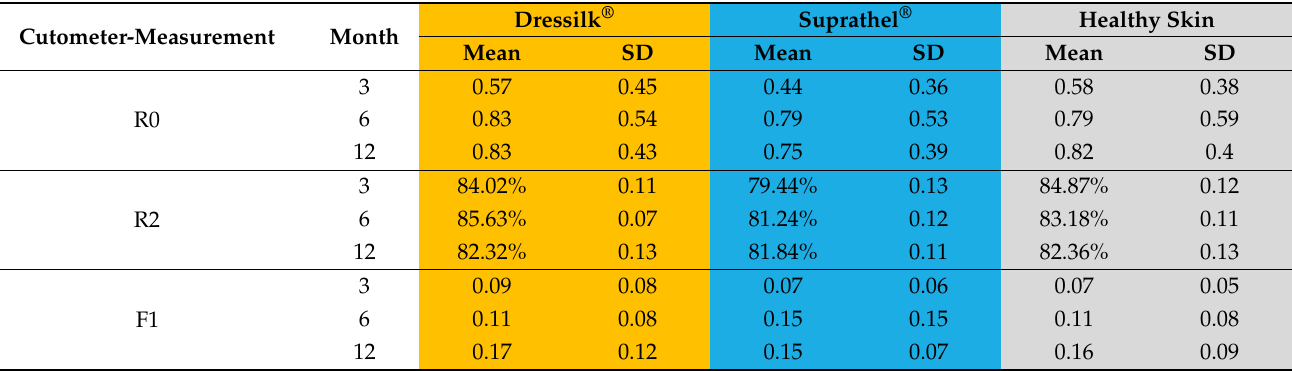
Table 2. Cutometer R 0 -values (stretchability/firmness) in mm and R 2 -values (visco-elasticity) in %, F1-values (elasticity) in mm 2 after 3, 6 and 12 months of areas treated initially with Suprathel, Dressilk and the uninjured control area.